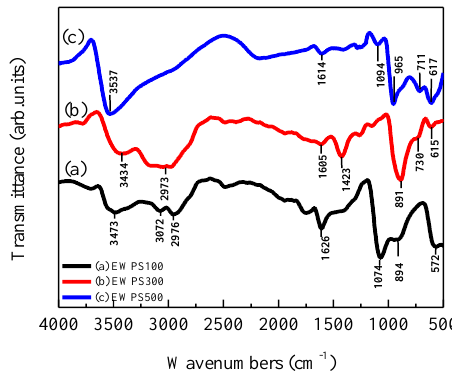
Figure 3. Fourier transform infrared (FT-IR) spectra of EWPS films: ( a ) EWPS100 (annealed at 100 °C); ( b ) EWPS300 (annealed at 300 °C); ( c ) EWPS500. The annealing process at 500 °C led to PEO pyrolysis and formation of W–O–W and Si–O–Si structures.